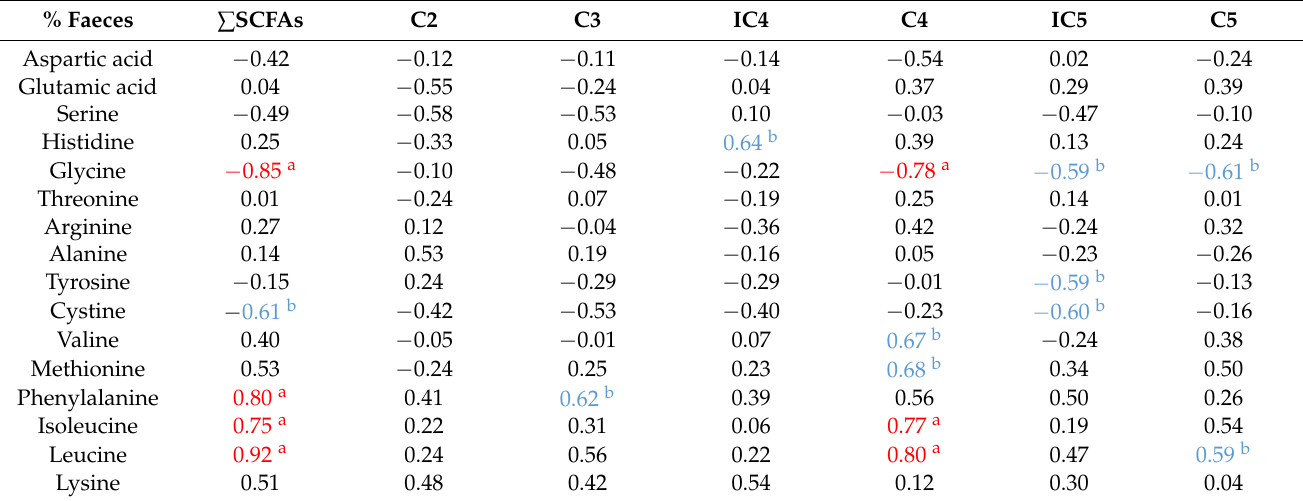
Table 4. Correlation coefficients between faecal amino acids proportions and faecal short-chain fatty acids (SCFAs, mmol/g dry matter).